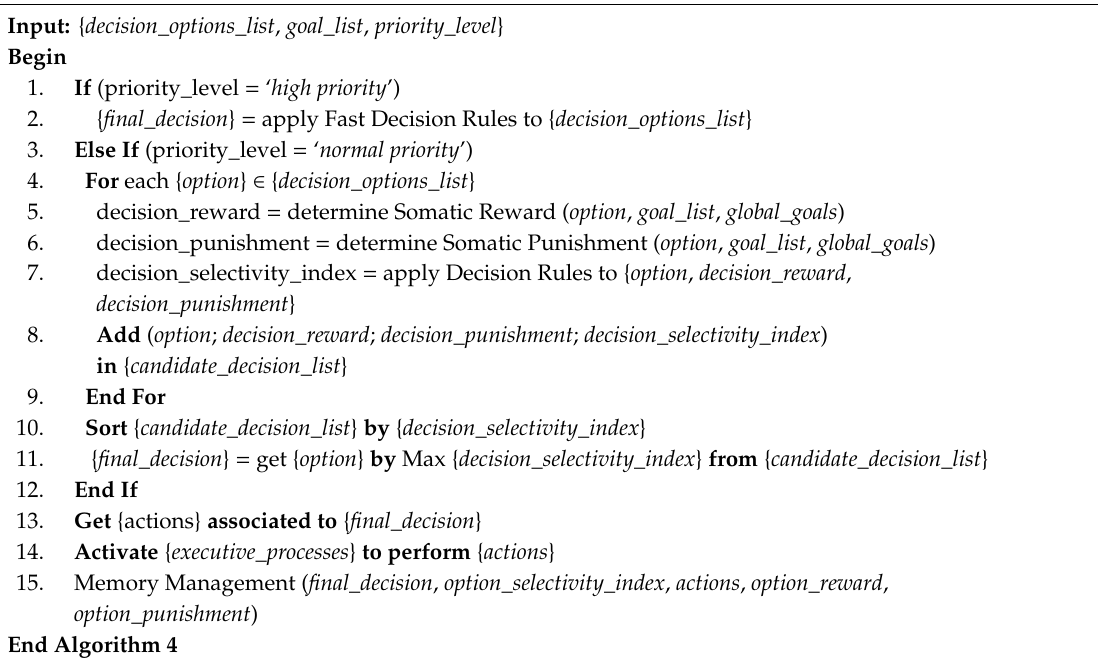
Algorithm 4 Decision Selection and